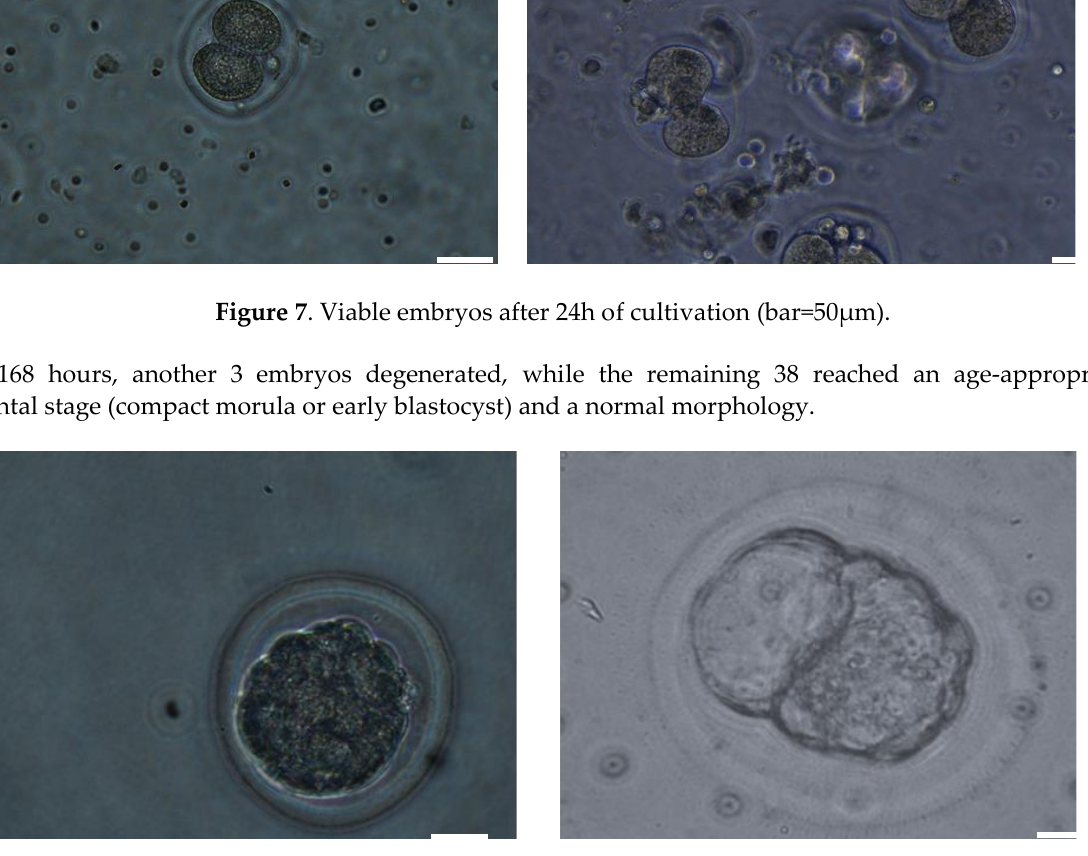
Figure 8 . Viable embryos after 168h of cultivation (left: compact morula, right: early blastocist,